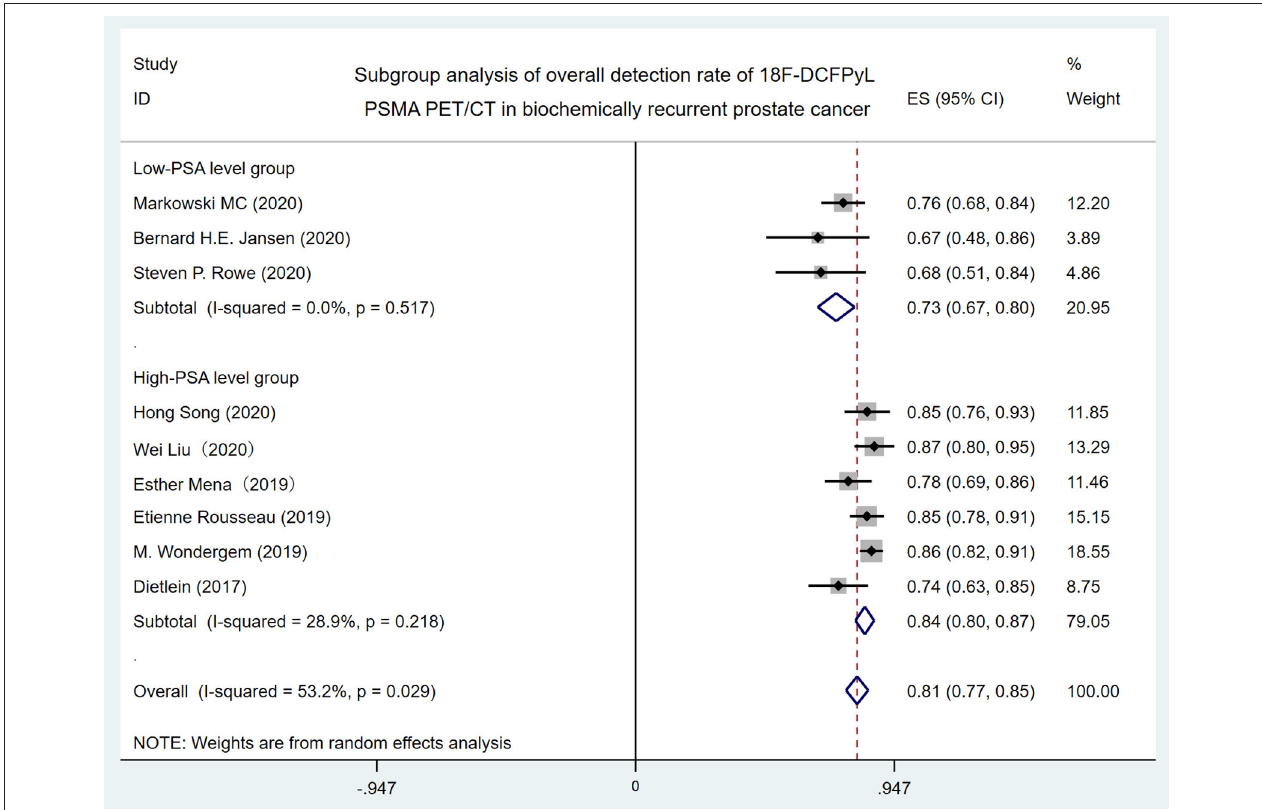
FIGURE 3 | Forest plot for subgroup analysis of overall detection rate of 18F-DCFPyL PSMA PET/CT in biochemically recurrent prostate cancer. 18F-DCFPyL, 2-(3-{1-carboxy-5-[(6-[18F] fluoro-pyridine-3-carbonyl)-amino]-pentyl}-ureido)-pentanedioic acid; PSMA, prostate-specific membrane antigen; PET/CT, positron emission tomography/computed